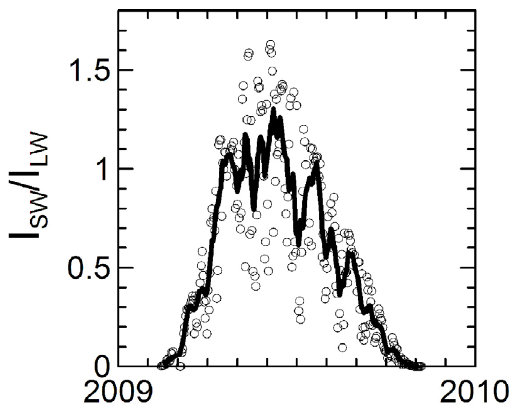
Figure 11. Ratio of the shortwave to longwave irradiance measured at Thule in 2009.